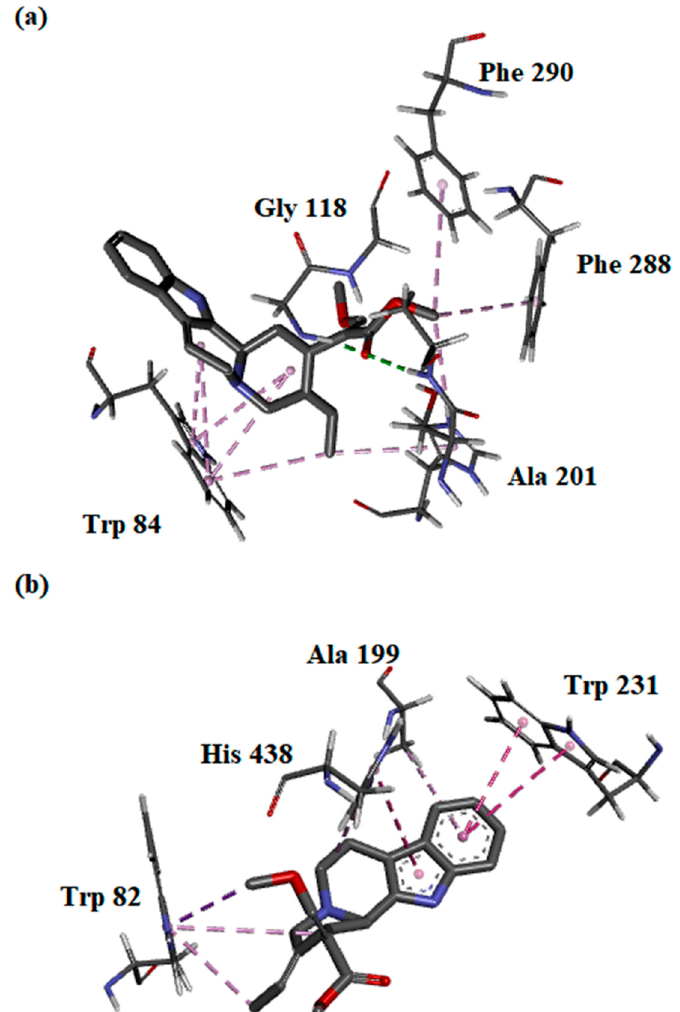
Figure 3. Binding orientations and interactions of compound ( 2 ) with protein residues at the active site of ( a ) acetylcholinesterase and ( b ) butyrylcholinesterase.